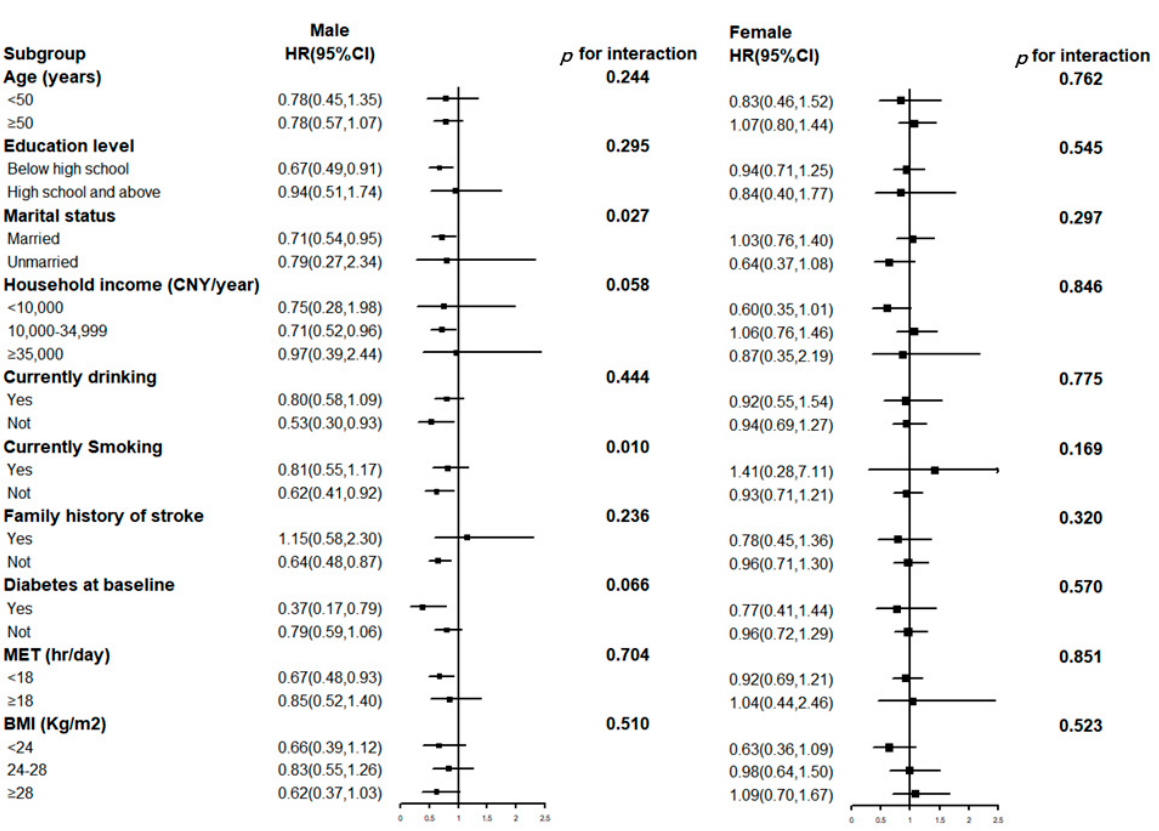
Figure 1. Subgroup analyses of the association between egg consumption and cerebrovascular disease (CED) according to baseline characteristics. Multivariate models were adjusted for age, gender, education level, marital status, household income per-year, alcohol consumption status, smoking status, daily food consumption of rice, wheat, other staple foods, red meat, poultry, fish, dairy prod- ucts, fresh fruit, soybean products, preserved vegetables, MET, BMI, family history of stroke and prevalent diabetes at baseline. Black squares indicate point estimates, horizontal lines indicate the 95% CIs. The tests for interaction were performed using likelihood ratio tests. p for interaction: com- paring models with and without interaction terms between the strata variable and egg consumption.